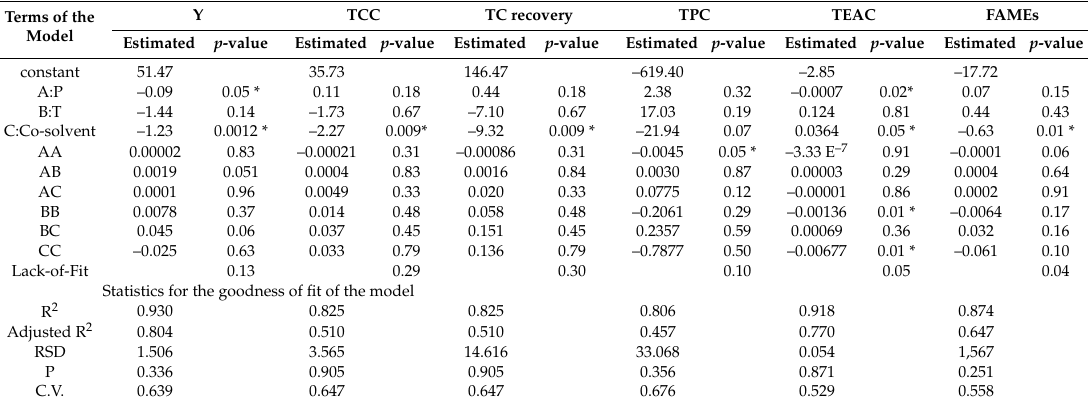
Table 1. Regression coe ffi cients (values of variables are specified in their original units, extraction yields (Y), total carotenoids content (TCC), TC recovery, total phenol content (TPC), Trolox equivalents antioxidant capacity (TEAC) antioxidant method), fatty acid methyl ester (FAMEs), and statistics for the fit obtained by multiple linear